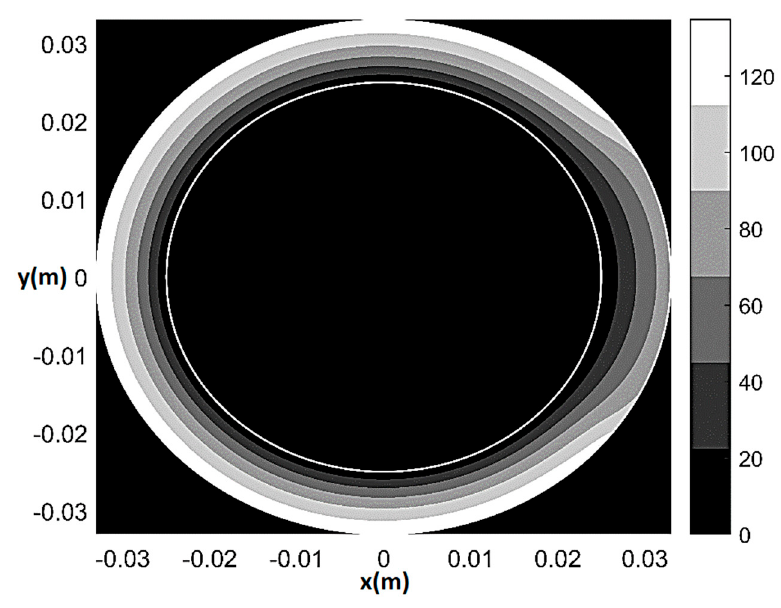
Figure 7. Pressure contour plot under stress for 80% CX stenosis ( q 0 = q 0 H = 2.7 × 10 − 9 m 2 /s, T / T H = 0.8055, ξ = 0.55, Θ s = 72°, δ given by (28)). Pressure values in mmHg.